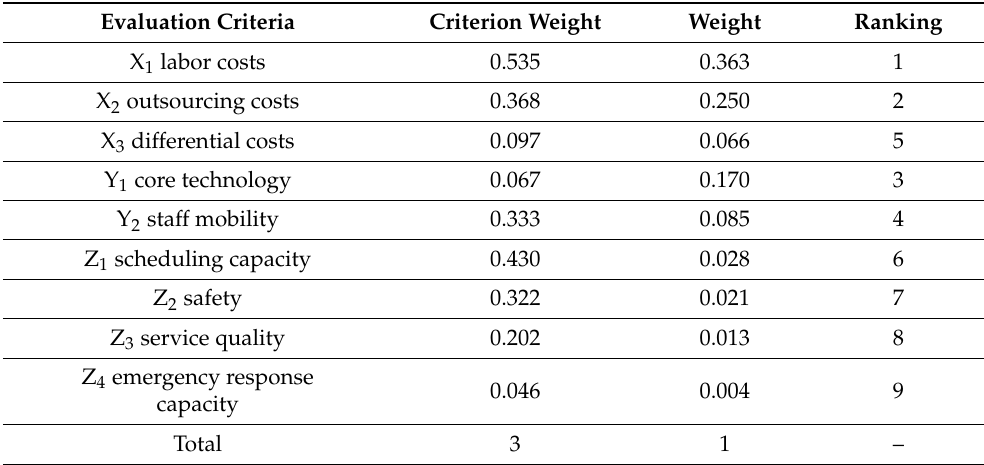
Table 4. The criterion weight, weight, and ranking of evaluation criteria in the 3rd layer with the electromechanical system as an example. Evaluation Criteria